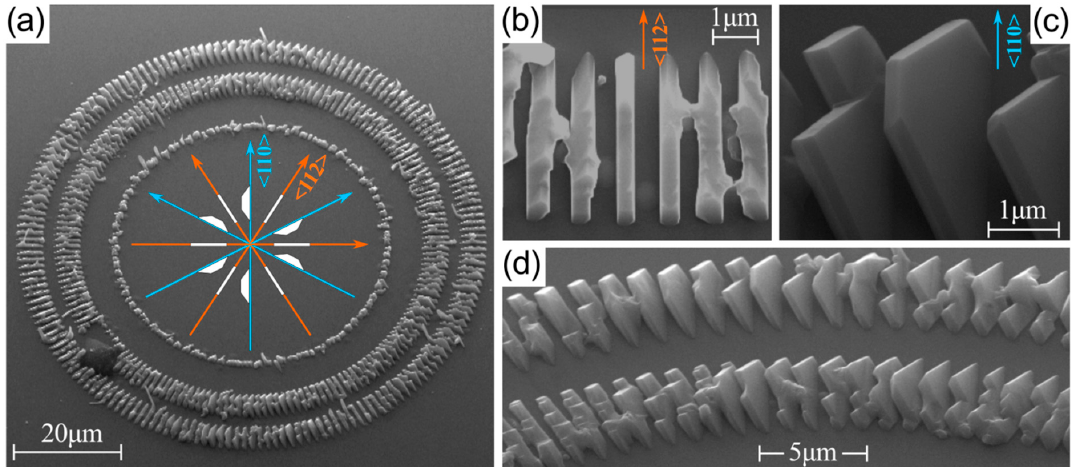
Figure 3. SEM images of GaAs fins grown on a circular pattern. ( a ) tilted view of the full pattern, with an angular spacing between fins of 2°. White schemes illustrate the repetition of the fin morphologies along the circle; ( b ) top view of a fin along a <112> direction and ( c ) tilted view of a slanted fin along a <110> one; ( d ) tilted view of a representative portion of the pattern.